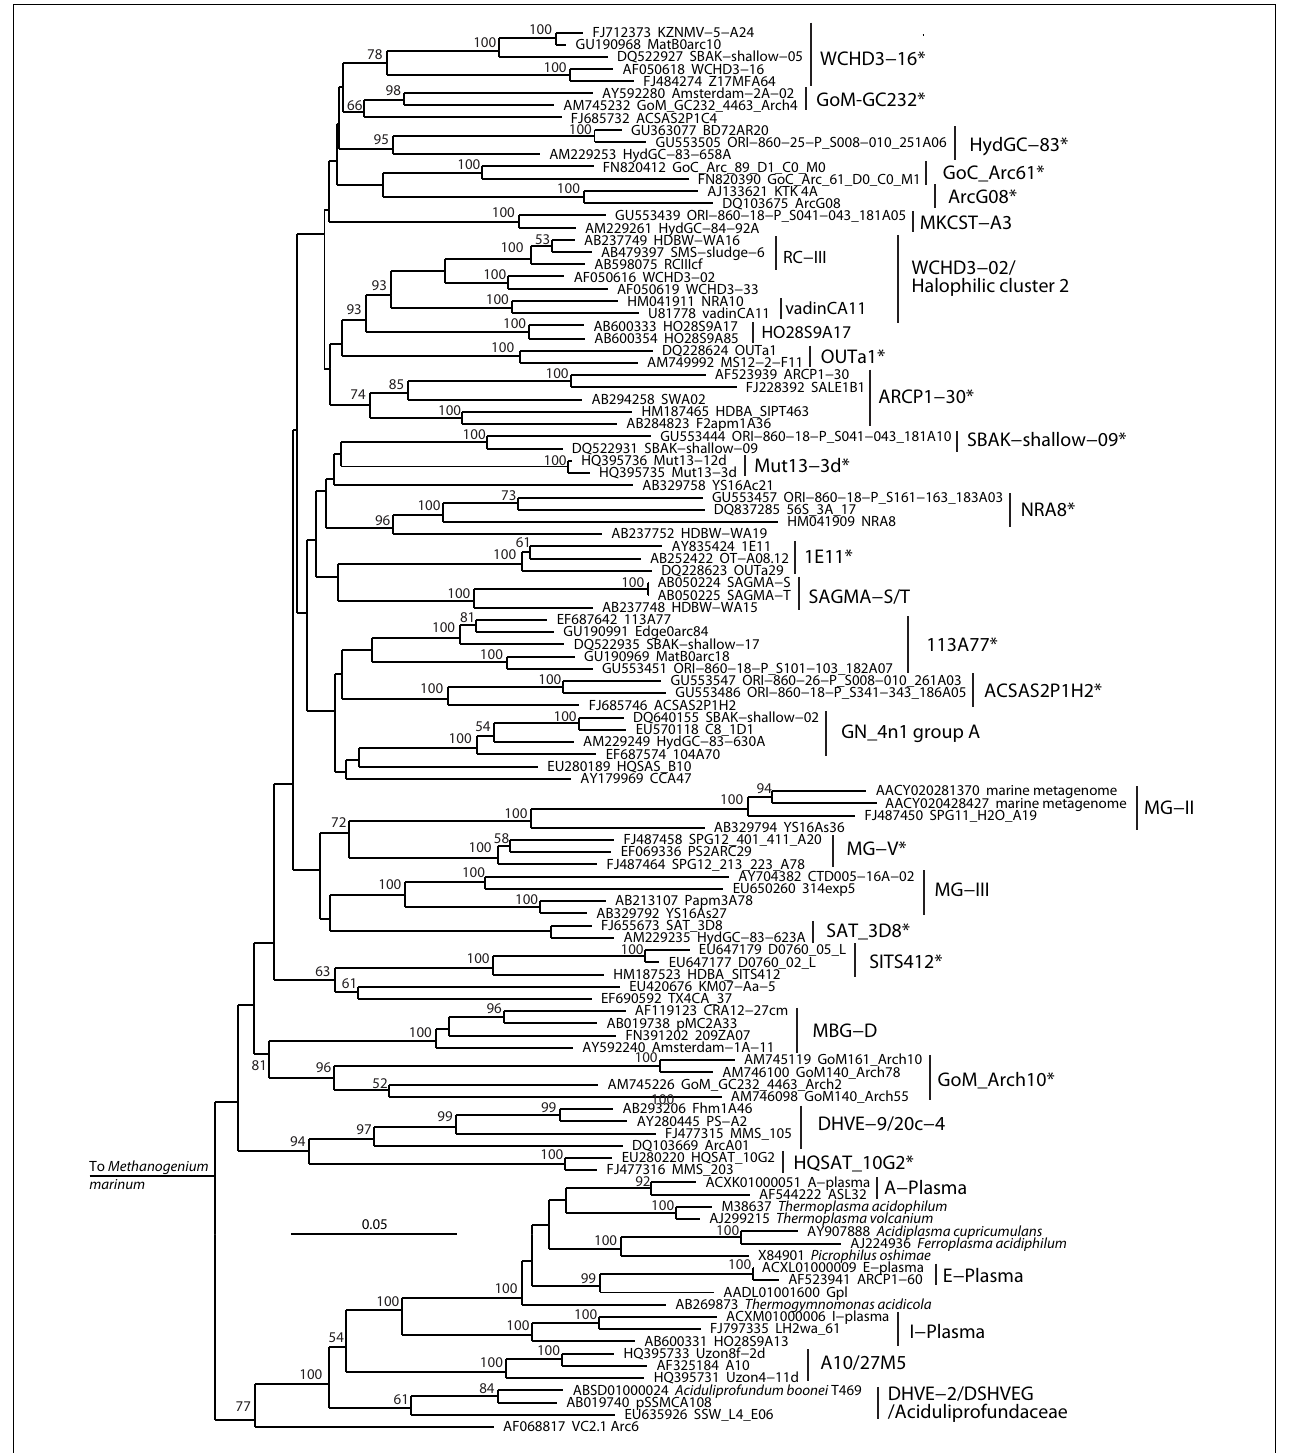
bootstrap replications inTreeFinder (Jobb et al., 2004). Branches are annotated with names and acronyms that are used in the literature ( Table 3 ). The archaeal taxa marked with asterisks are novel designations introduced either in Durbin andTeske, 2011 or in this study ( Table 3